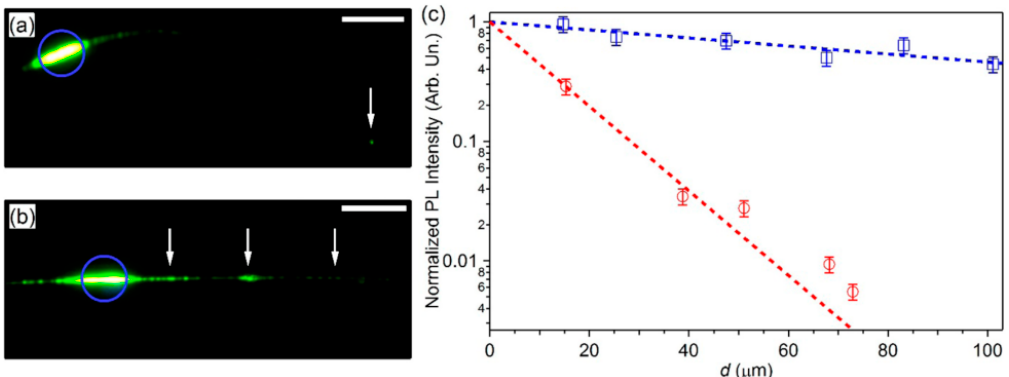
Figure 9. Waveguiding micrographs of polymer spun fibers in ( a ) controlled atmosphere and ( b ) air, and excited by a focused laser (blue circles). Scale bars = 20 µm. White arrows in ( a , b ) show the fiber tip and defects along the fiber axis, respectively. ( c ) Waveguided PL intensity along a single fiber versus propagation distance d, with fibers electrospun in controlled atmosphere (blue squares) and air (red circles). Dashed lines: exponential fit to decay (the whole Figure 9 was reprinted with permission from Fasano et al. [47]).